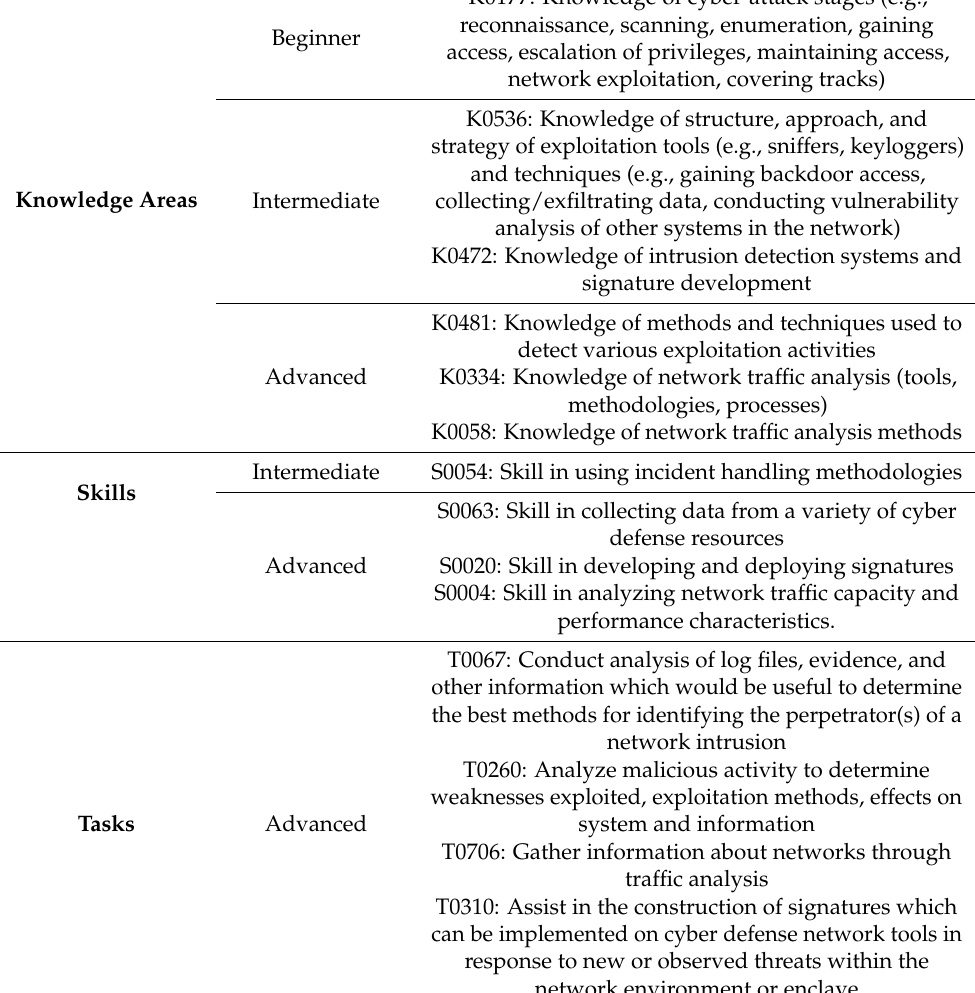
Table 1. Knowledge Skills and Tasks for Computer Network Defense.